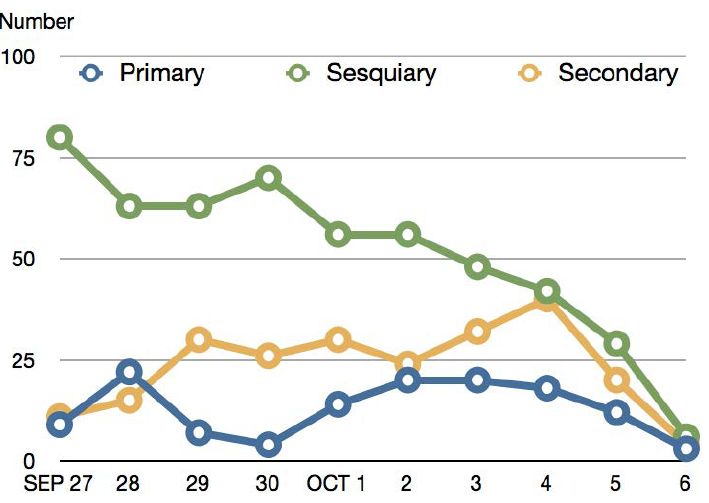
Figure 14. Change in number of tweets each